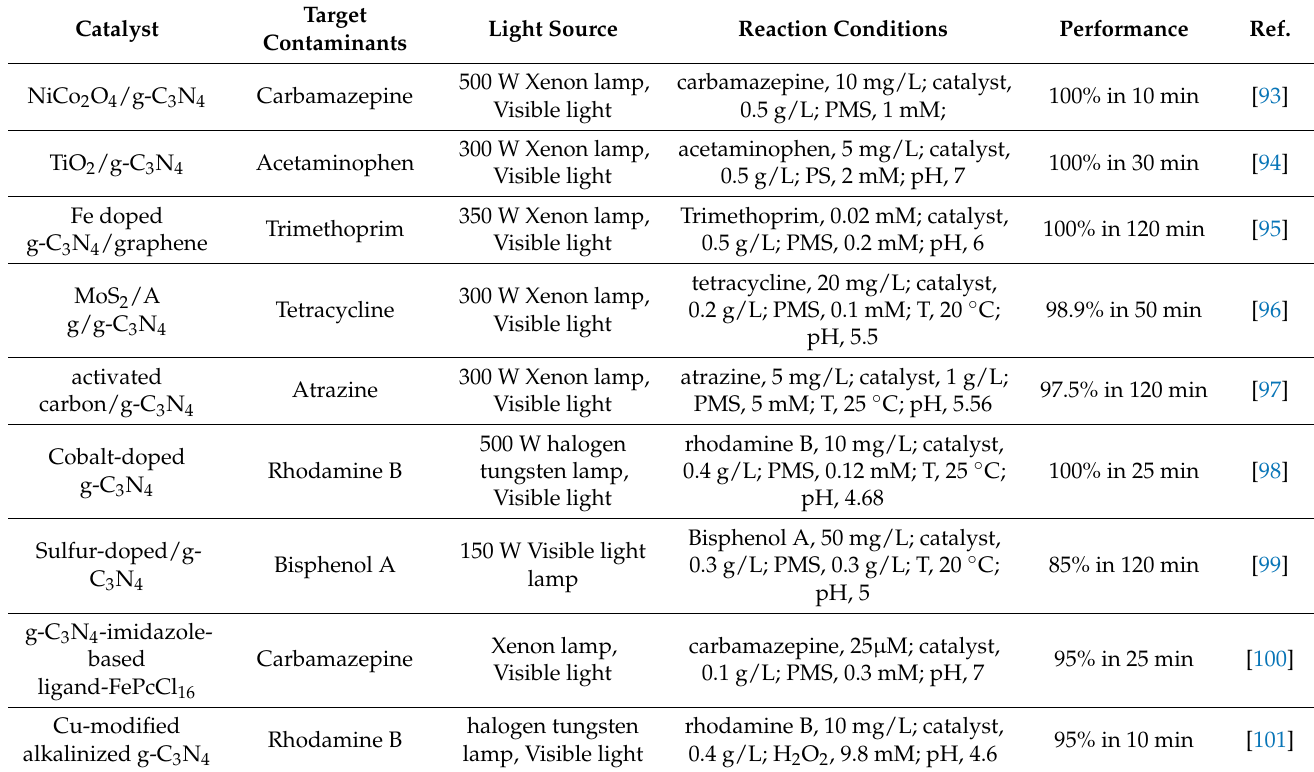
Table 2. g-C 3 N 4 based composites for photochemical